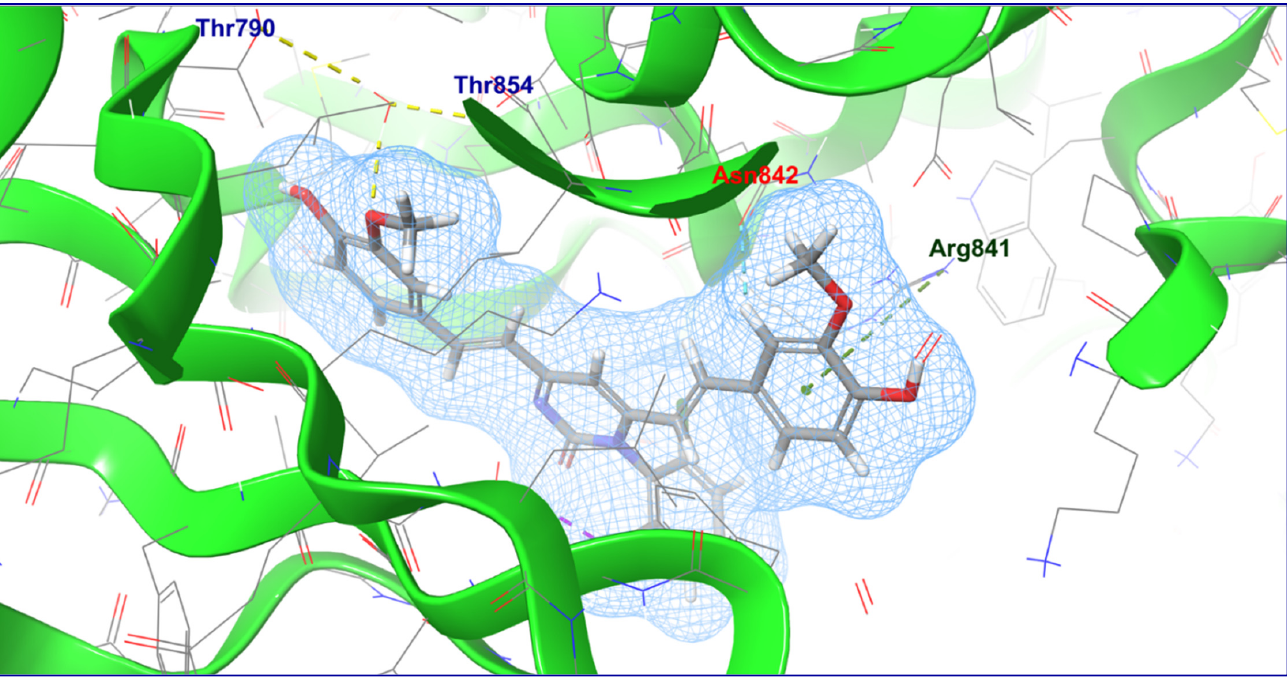
Figure 7. The 3D interactions of ligand C2 against the active site of EGFR (binding affinity = − 5.086